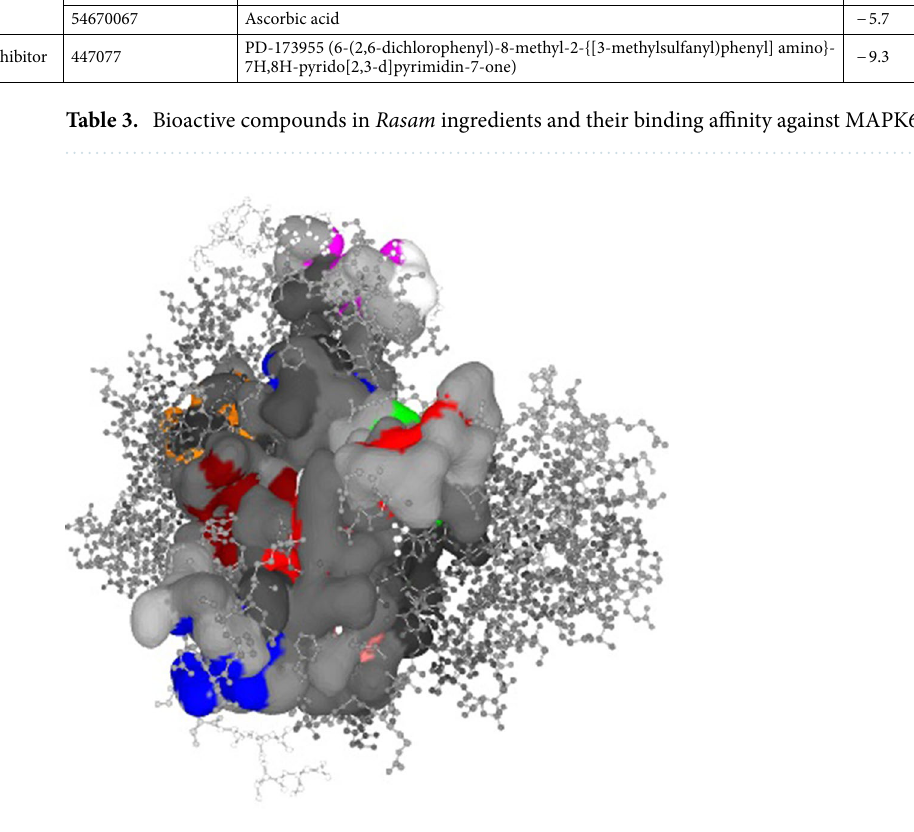
Figure 2. Showing active site and correspondence binding site of MAPK6 protein. Eleven binding pockets were predicted with different colour. Binding pocket 1 (17 AA with predicted score 9.16), pocket 2 (14 AA